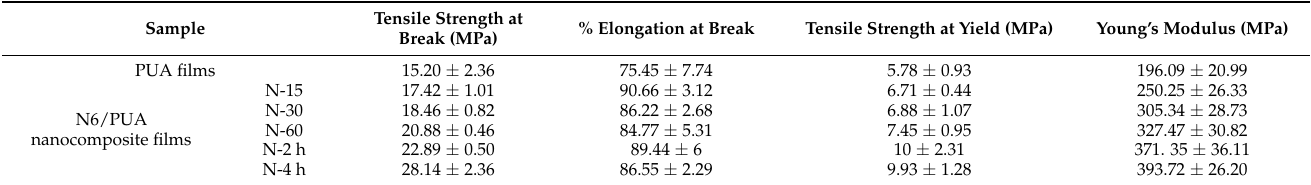
Table 2. Mechanical properties of the N6/PUA nanocomposite films (modified from ref. [16]. copyright 2021 Wiley-VCH).